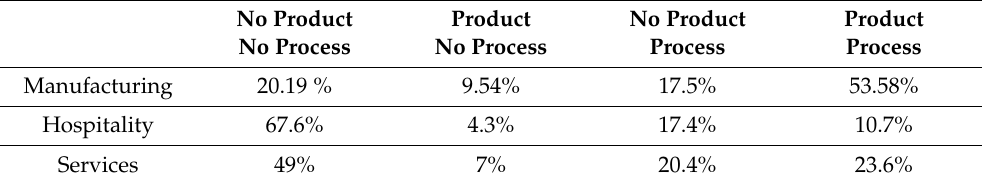
Table 10. Product and process innovation by industry (% total).